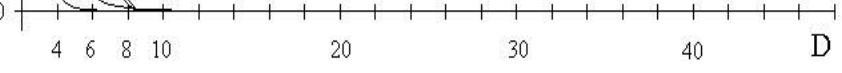
Fig. 12. Dependence ( ) f D  for various signal